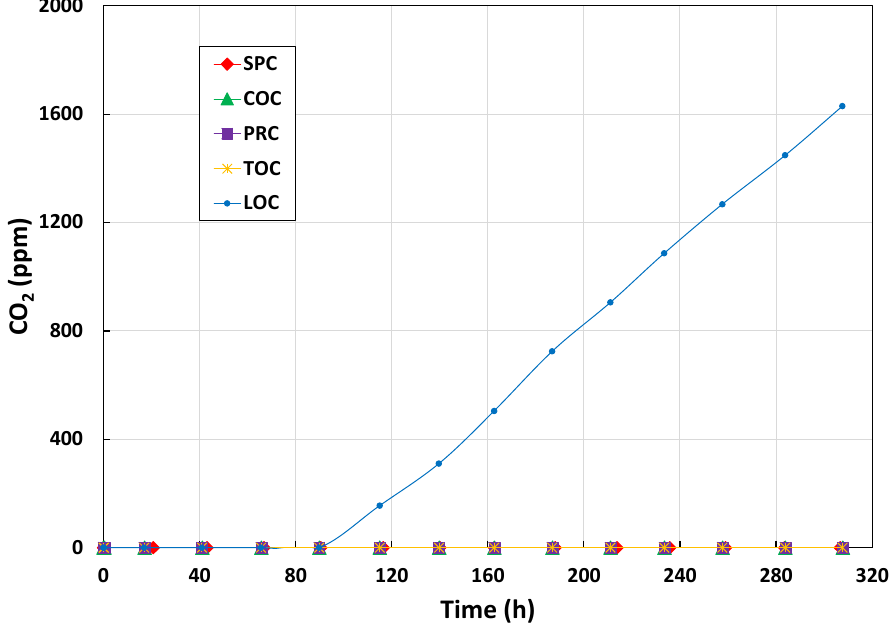
Figure 2. Cumulative carbon dioxide (CO 2 ) mean concentrations in the containers over the thirteen-day test period for each of the five materials. Pellets made from: SPC—100% synthetic pure cellulose, COC—cellulose plus 10% coconut oil, PRC—cellulose plus 10% pine rosin, LOC—cellulose plus 10% linseed oil, TOC—cellulose plus 10% tall oil.